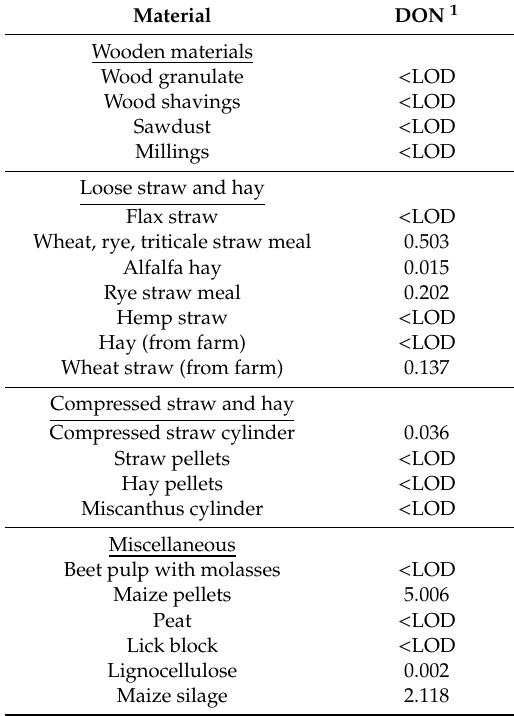
Table 4. Concentration of deoxynivalenol (DON) in the tested organic materials in mg mycotoxin / kg material based on a dry matter content of